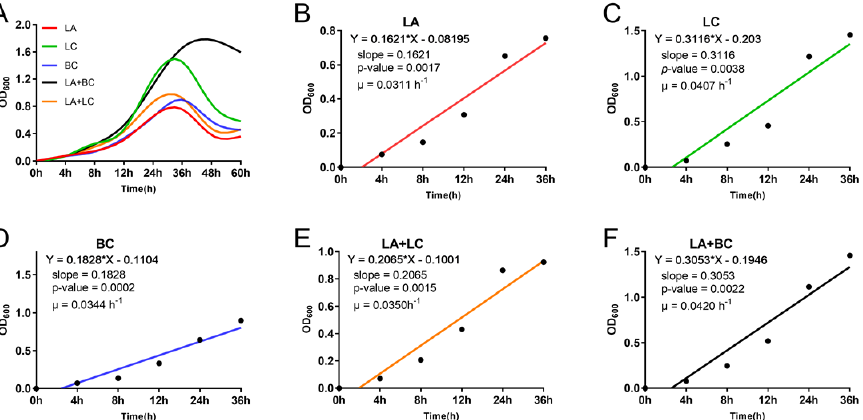
Figure 2. The growth dynamics of biocontrol agents (BCAs) when cultured as single strain and co-culture. ( A ) The full growth curves of BCAs as single strain and co-culture during the incubation. ( B–F ) The growth rates of each BCAs as single strain and co-culture.